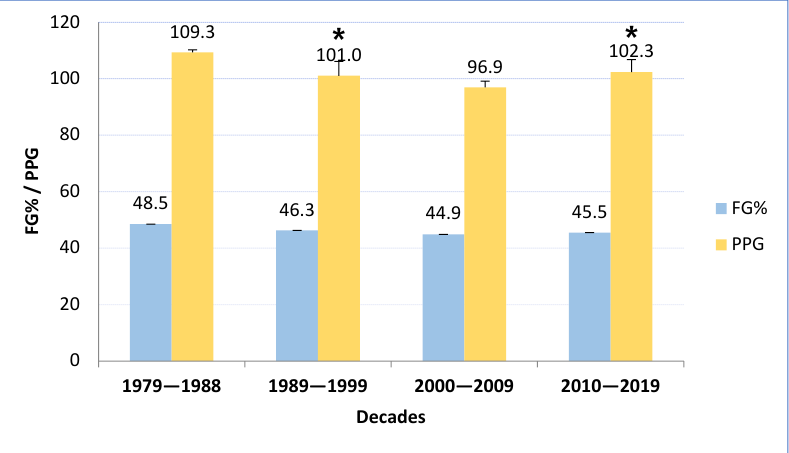
Figure 4. Total field goal percentages compared with total points scored per game over four consec- utive NBA decades. * Statistically significant compared with the previous decade with p < 0.05.